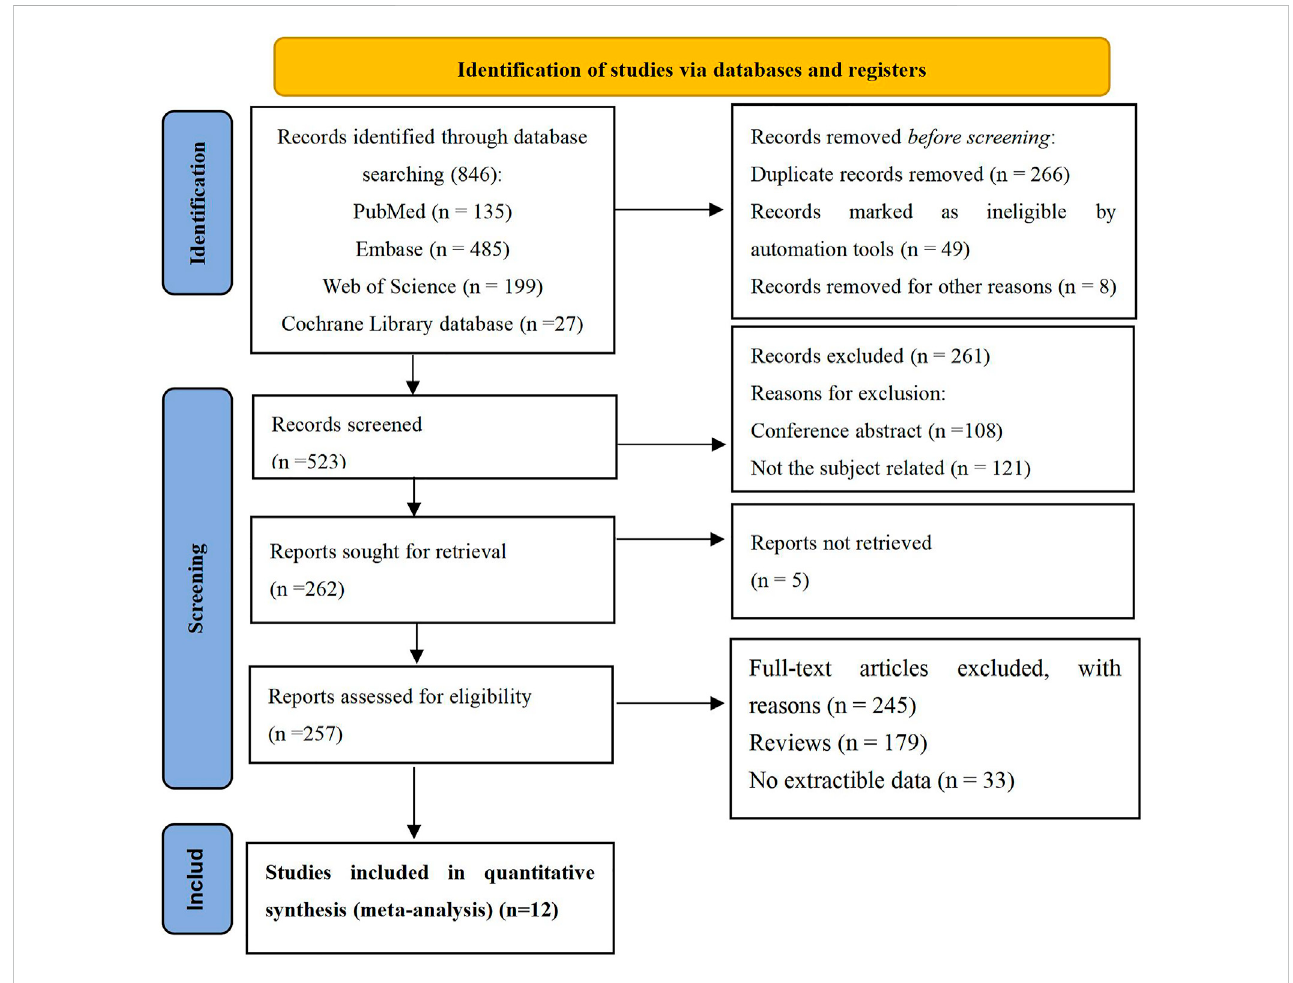
FIGURE 1 Flow chart of the literature